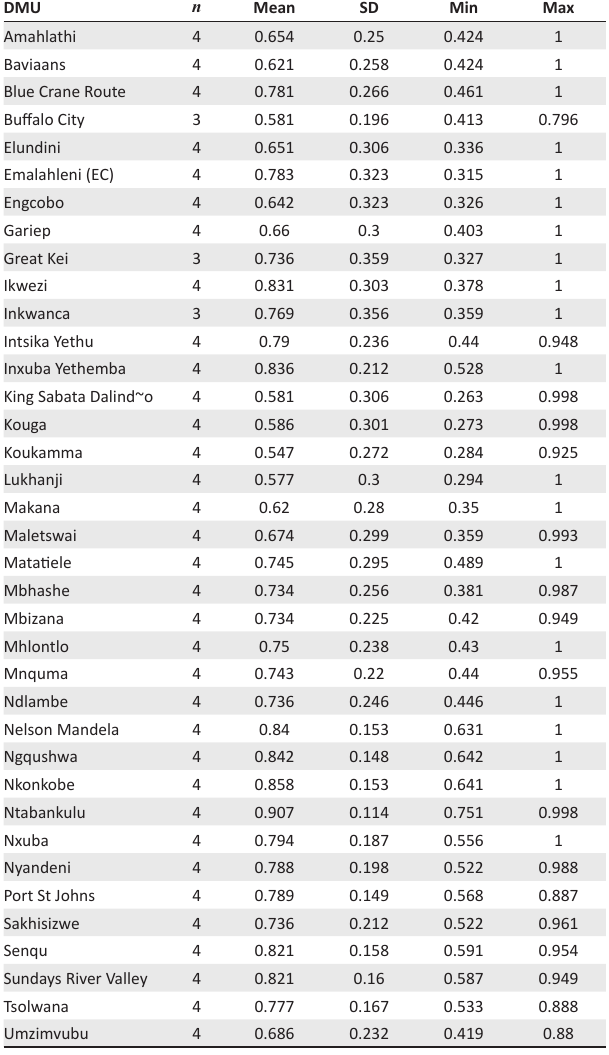
TABLE 6: Summary